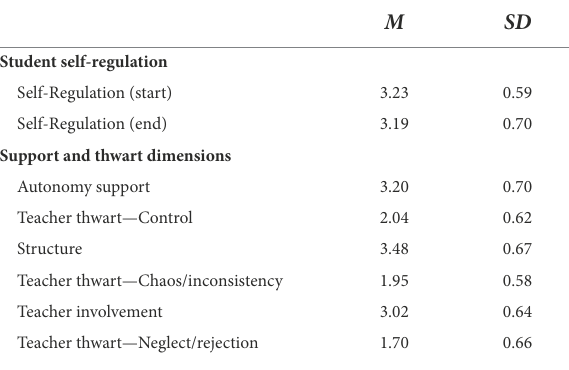
TABLE 1 Means (M) and standard deviations (SD) for students’ self- regulated learning and teacher support and teacher thwart